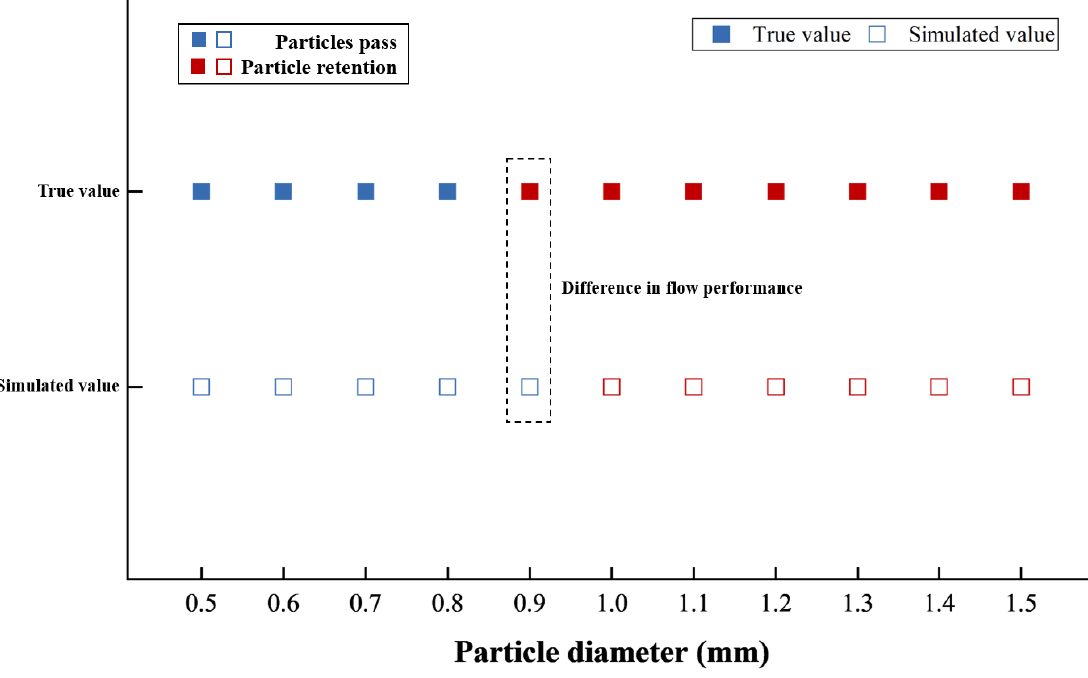
Figure 6. Flow properties of materials for plugging while drilling with different particle size in mud screen.